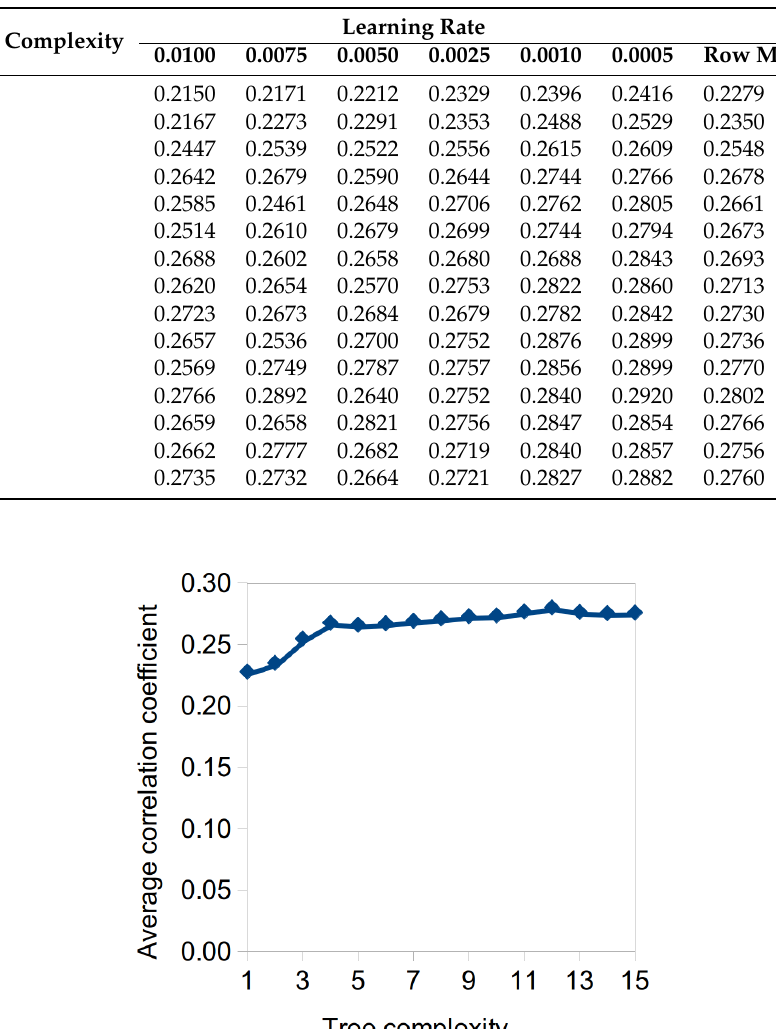
Table A1. Parameter calibration for boosted regression trees for models of forest conversion to development, 2001–2011. Ten-fold cross-validation correlation coefficients were determined for all combinations of tree complexity from 1–15 with six learning rates ranging from 0.01–0.0005. The mean correlation coefficients across learning rates are shown.